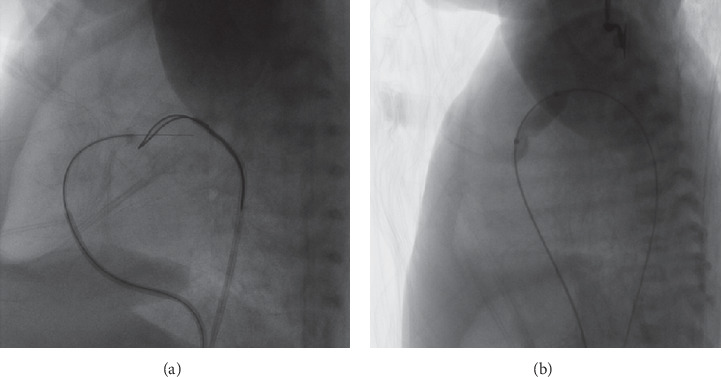
(a). Perforation was performed with the Conquest Pro, and the femoral vein-ductus-femoral artery pathway was built with a snare to trap the microguide wire; (b) balloon dilation was manipulated with a microballoon of a diameter 1–1.2 times that of the pulmonary valve annulus.